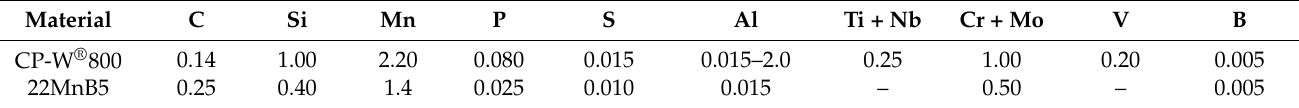
Table 1. Chemical composition of CP-W ® 800 [18] and 22MnB5 [19] in